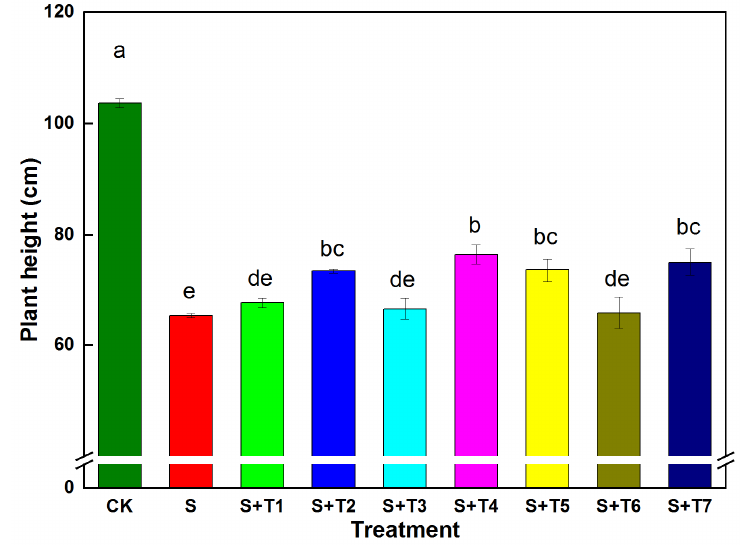
Figure 1. Effects of EBR spraying on rice plant height at full-ripening stage under salt stress. S indicates salt concentration of 3.0 g kg − 1 NaCl; S+T1 to S+T7 indicate the EBR spraying at transplanting, panicle initiation, heading, transplanting + panicle initiation, transplanting + heading, panicle initiation + heading, and transplanting + panicle initiation + heading stages, respectively, under salt stress. The data (n = 3) are mean values ± SD, calculated from three independent experiments. The different letters indicate significant differences at p < 0.05.